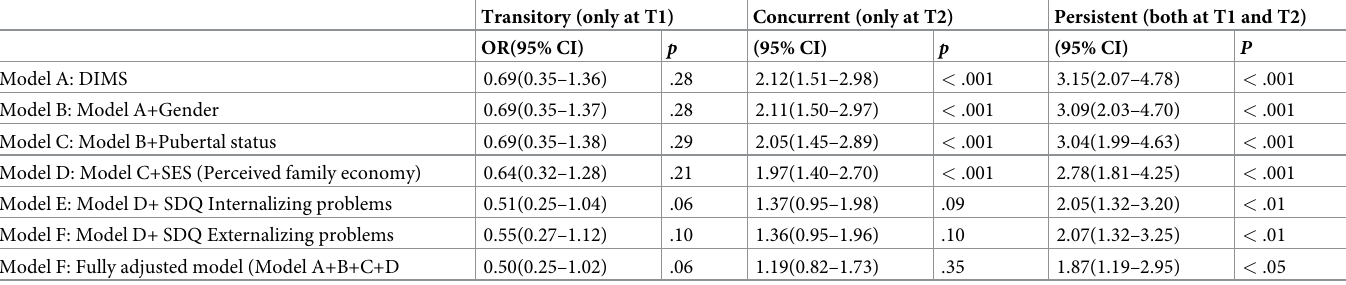
Table 2. Sleep problems and school performance. Logistic regression models analyzing the relationship between sleep problems and poor school performance at T2 in children transitory, concurrent or persistent DIMS (Difficulties initiating and maintaining sleep; N =